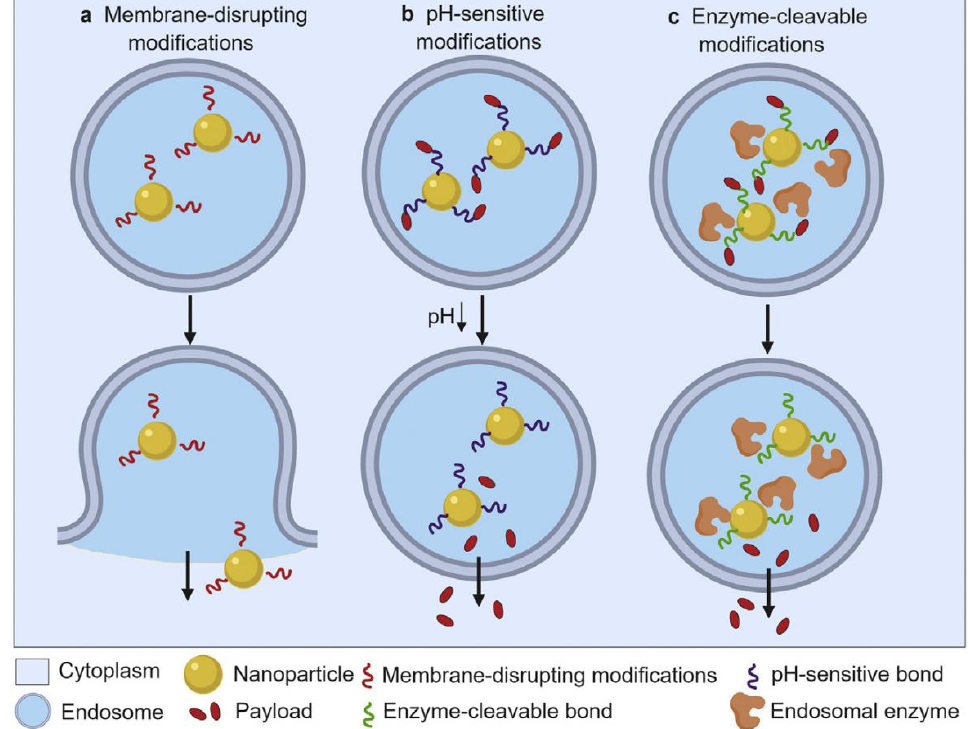
Figure 8. Examples of cytoplasmic delivery via endosomal escape. Three main strategies are available for nanoparticles to break through and escape endosomal barriers. ( a ) Membrane-disrupting surface modifications and mechanisms (e.g., poly(ethyleneimine) PEI; cell-penetrating peptides (CPPs); and lipid fusion with endosomal membrane); ( b ) pH-responsive materials (e.g., hydrazone bonds); and ( c ) enzyme-cleavable materials (e.g., ester linkages, cathepsin B cleavable peptides). Reprinted with permission from [174]. Copyright 2019